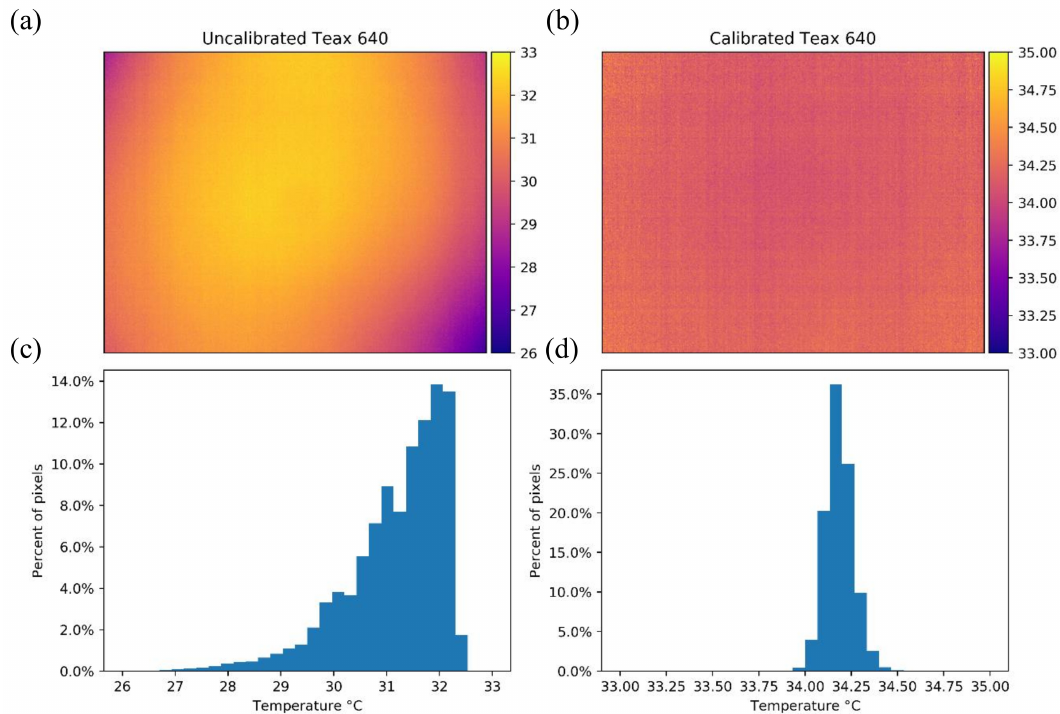
Figure 8. Temperature maps in Celsius and histograms for the TeAx 640 camera while looking at the black body with a temperature of 34.44 ◦ C. Panels ( a ) and ( c ) show the results before the calibration process and panels ( b ) and ( d ) depict the results of the same image after applying the calibration equation for each pixel to the whole